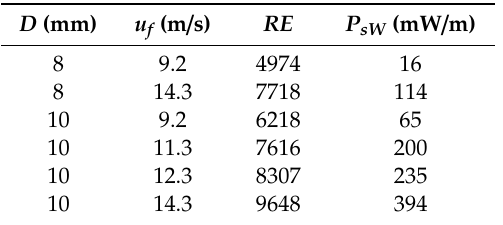
Table 7. Simulations results for the plate L = 50 mm, t p = 100 µ